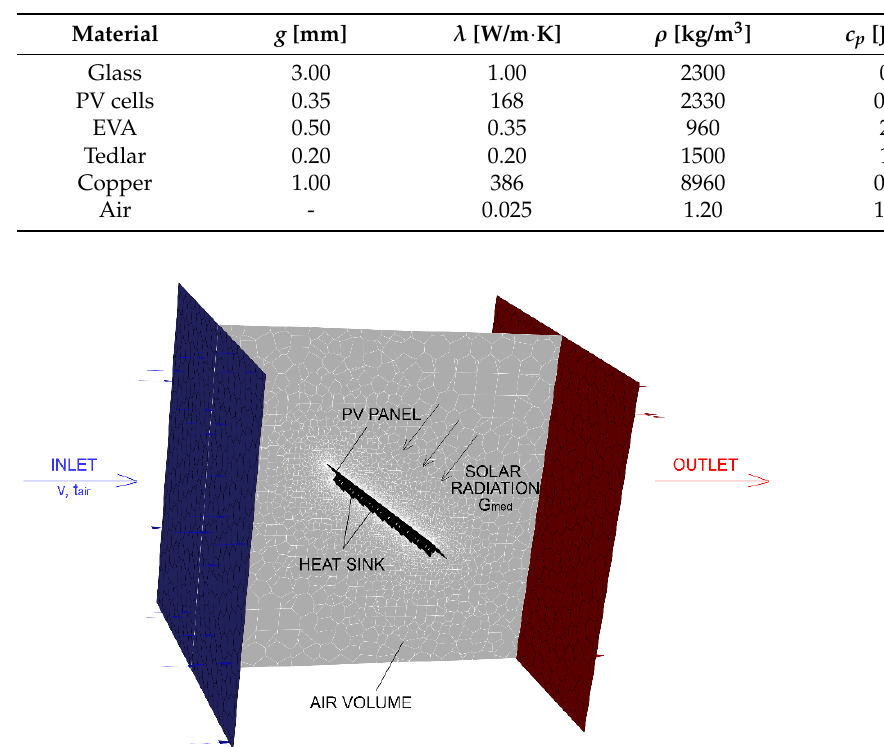
Figure 3. Main components of the numerical model.